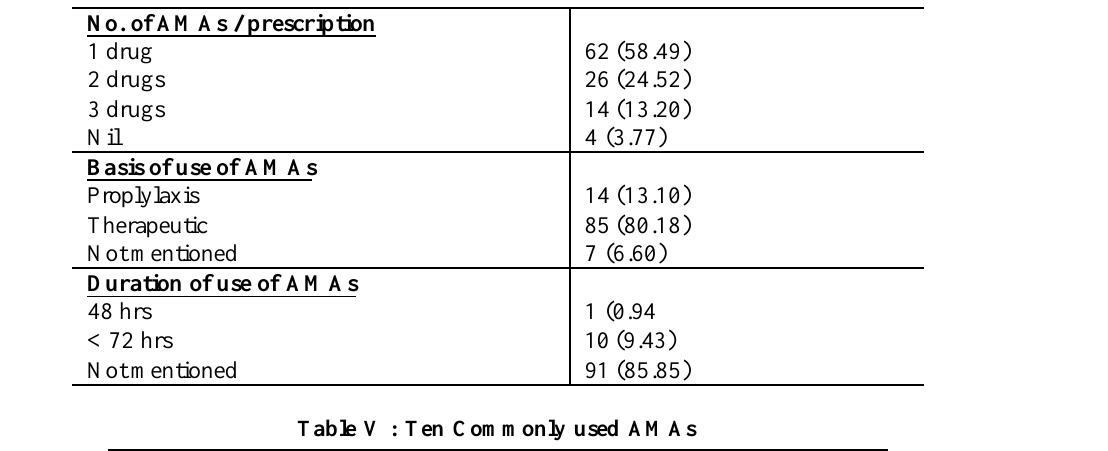
Table V : Ten Commonly used